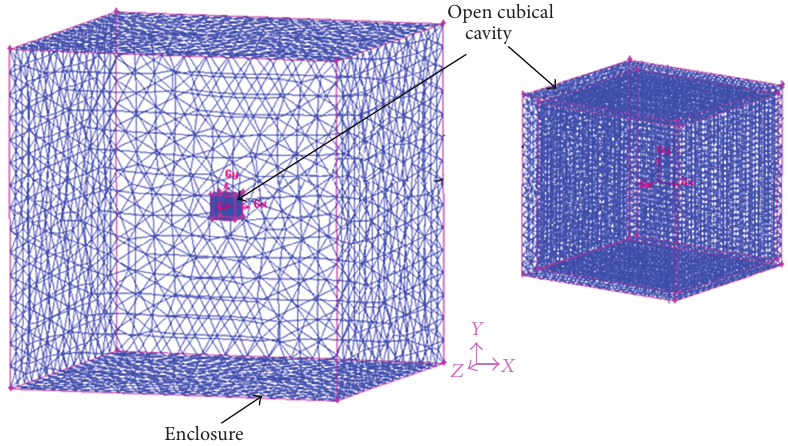
Figure 3: The mesh used for the open cubical cavity at 0 ∘ inclination along with the enclosure.